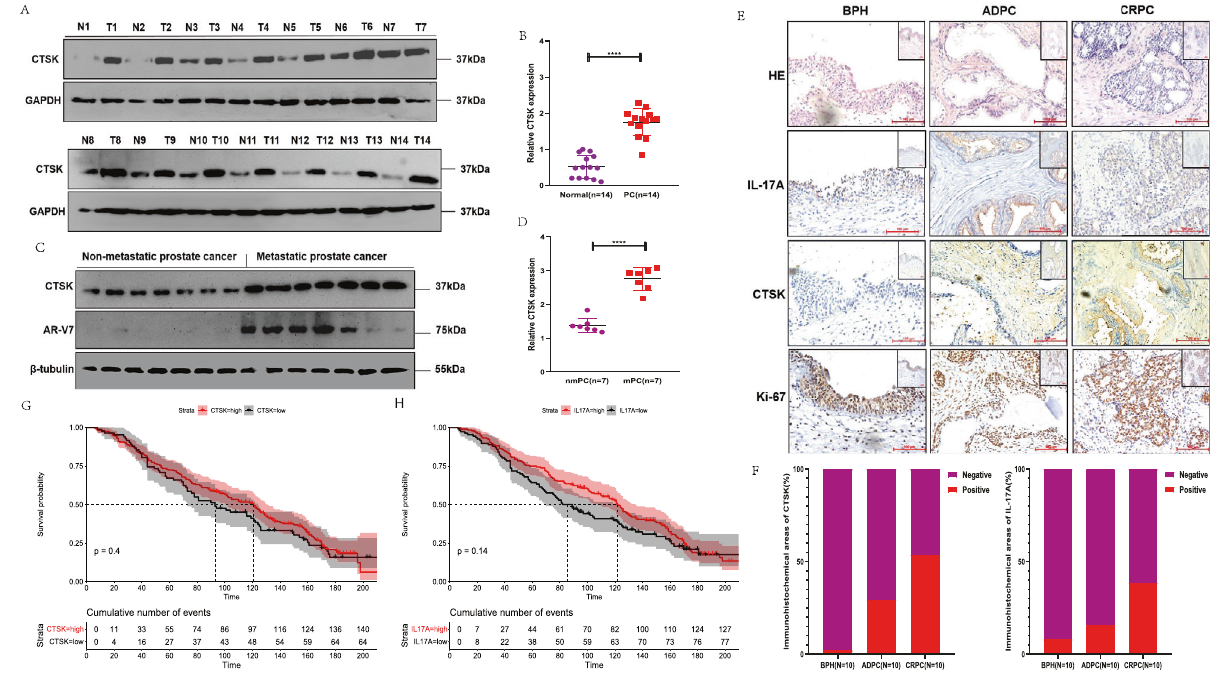
Fig. 2 Higher CTSK expression in metastatic prostate cancer/castration-resistant prostate cancer and the associated poor prognosis. A WB assay to examine the CTSK protein expression in CRPC tissues (T) and normal prostate tissues (N), GAPDH protein served as control. B The scatter diagram represents the relative CTSK expression in CRPC and normal tissues. C WB assay to examine the CTSK and AR-V7 protein expression in non-metastatic (nmPC) and metastatic (mPC) cancer tissues, β -tubulin protein served as control. D The scatter diagram represents the relative CTSK expression in nmPC and mPC tissues. E Comparing CTSK and IL-17A expression in BPH, ADPC, and CRPC groups by IHC staining. F The histogram represents comparison of the expression of CTSK and IL-17A in three kinds of groups. G Univariate analyses (log-rank) and Kaplan – Meier survival curves for PC patients with distinct CTSK expression levels. H Univariate analyses (log-rank) and Kaplan – Meier survival curves for PC patients with distinct IL-17A expression levels. Data are shown as mean ± s.e.m. * p <